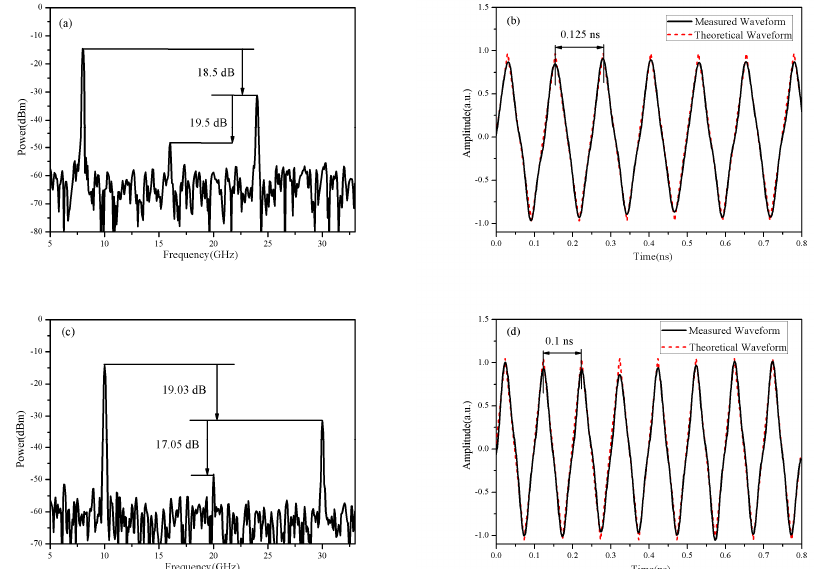
Figure 6. Electrical signal spectrum and waveforms of the generated triangular pulse trains with repetition rates of 8 GHz ( a ) and ( b ), 10 GHz ( c ) and ( d ).